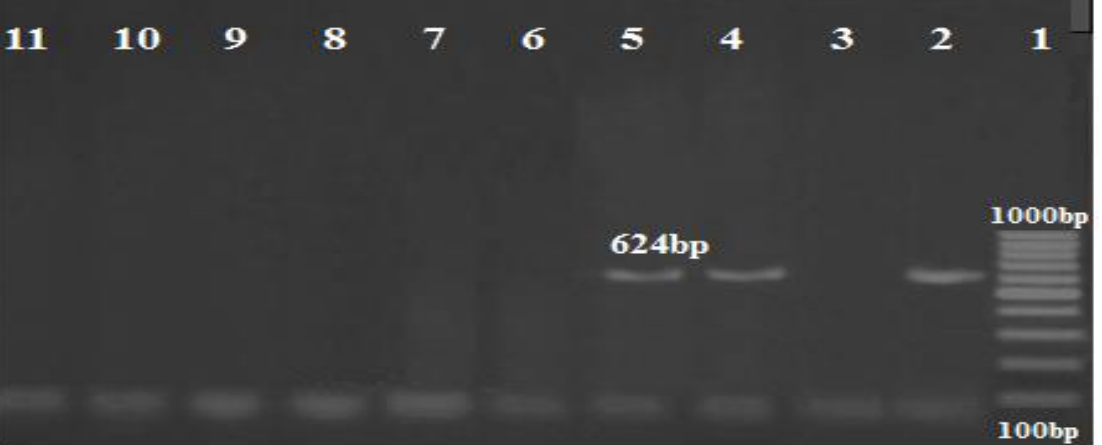
Figure 5. Amplification profile of the bla NDM gene (624 bp). Lane 1: DNA marker (100 bp ladder GoldBio Company, Cat.D001, US); lane 2: positive control; lane (4,5): positive for the bla NDM gene; lane 11: negative control.